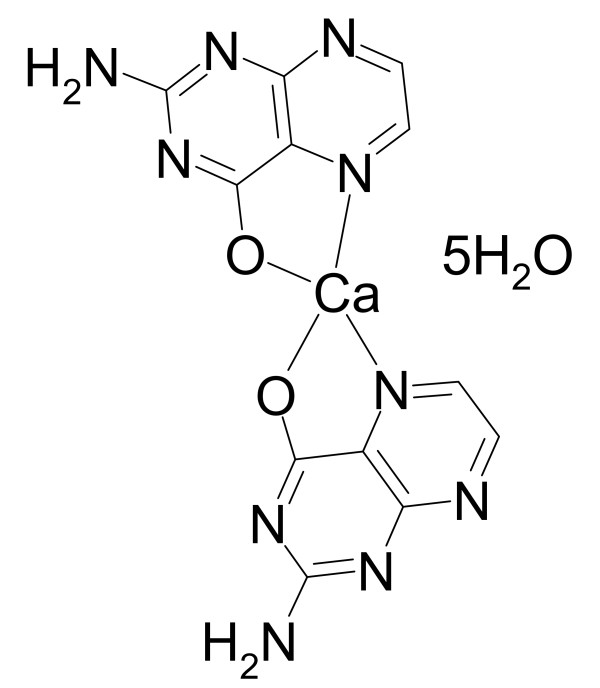
The structure of dipterinyl calcium pentahydrate, (C6H4N5O)2Ca·5H2O (MW 454.4). The X-ray crystallographic structure was given previously [3].